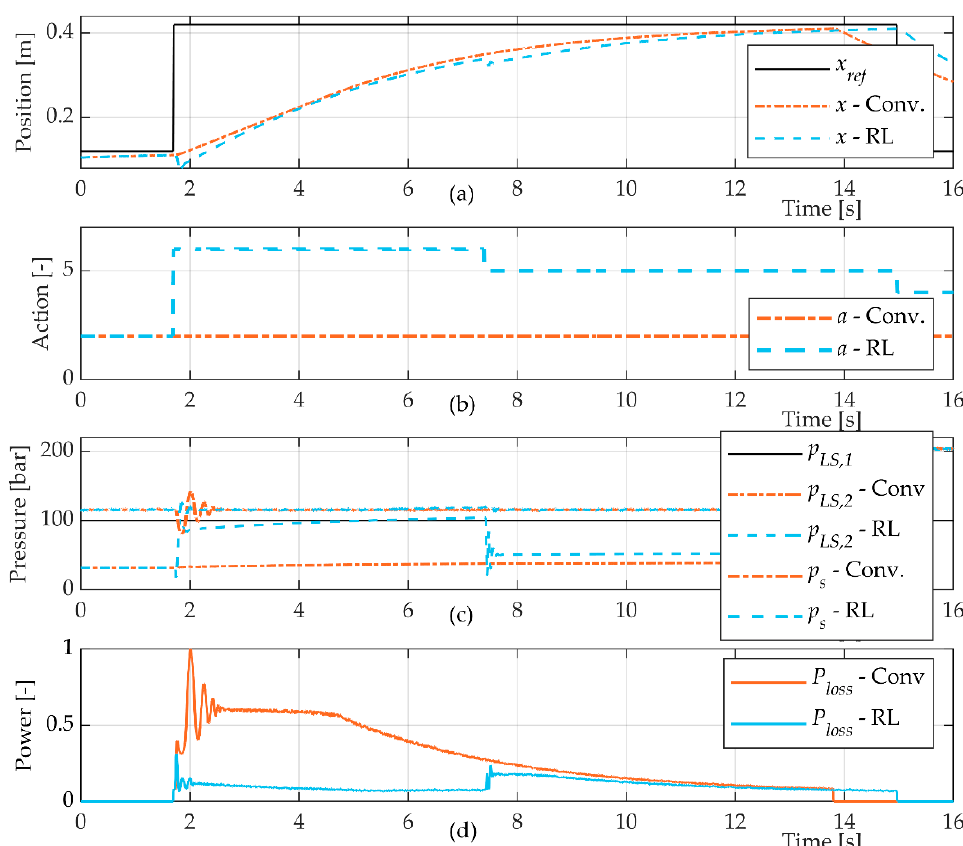
Figure 8. Simulation result, 40 kg load and p LS ,1 = 100 bar. ( a ) Position; ( b ) action; ( c ) system and load-sensing pressures; ( d ) power loss.